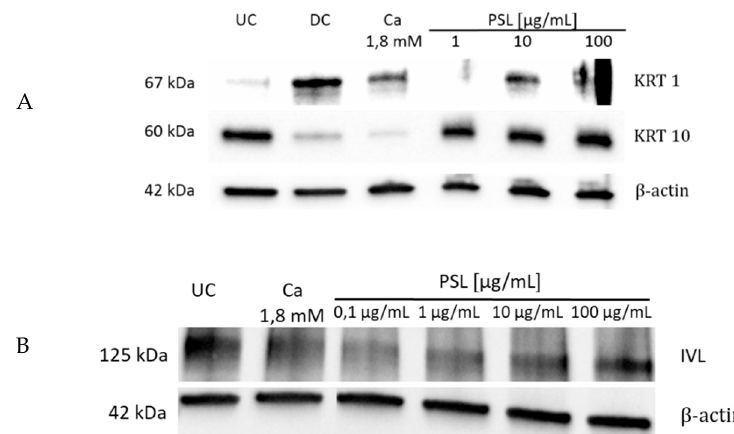
Figure 3. Influence of γ -PSL (1 to 100 µ g/mL) on the expression of differentiation-specific marker proteins KRT1, KRT10 ( A ), and IVL ( B ) in natural human epidermal keratinocytes (NHEK) after 7 days of incubation. Loading control: β -actin (10 µ g protein/sample); positive controls: Ca 2+ 1.8 mM; DC: Double cell density, contact inhibition; and UC: Untreated control. Note: KRT1 antibody partly produced artifacts.